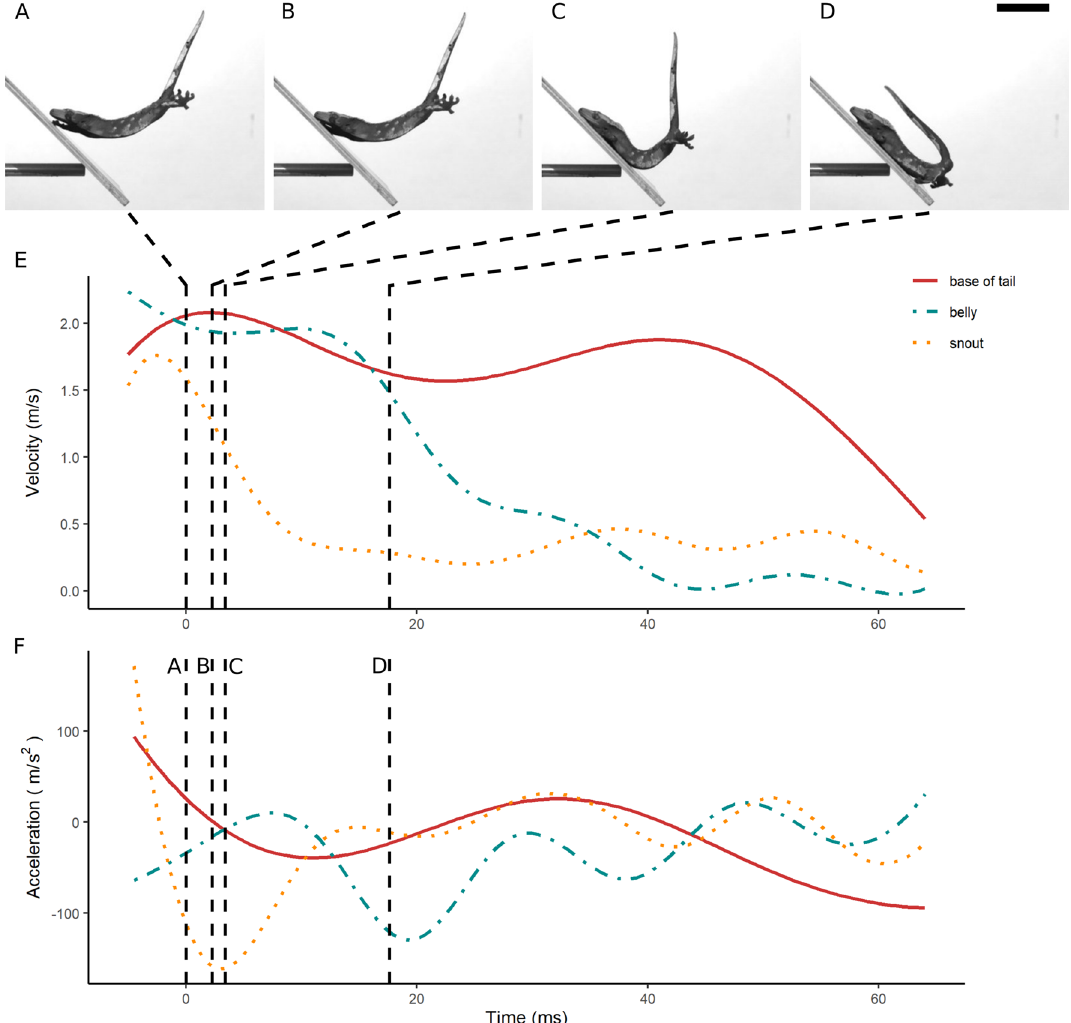
Figure 5. Representative landing process of a gecko jumping onto an inclined (45°) landing platform. ( A – D ) Frames showing the belly ( A ), the snout ( B ), the forelimbs ( C ) and the hindlimbs ( D ) initiating contact with the landing platform. The time point of each frame is indicated on the plot by a vertical dashed line. ( E ) Velocity of snout (yellow dotted line), belly (blue dashed line) and base of the tail (solid red line) during landing. ( F ) Acceleration of snout, belly and base of the tail during landing. Scale bar represents 5